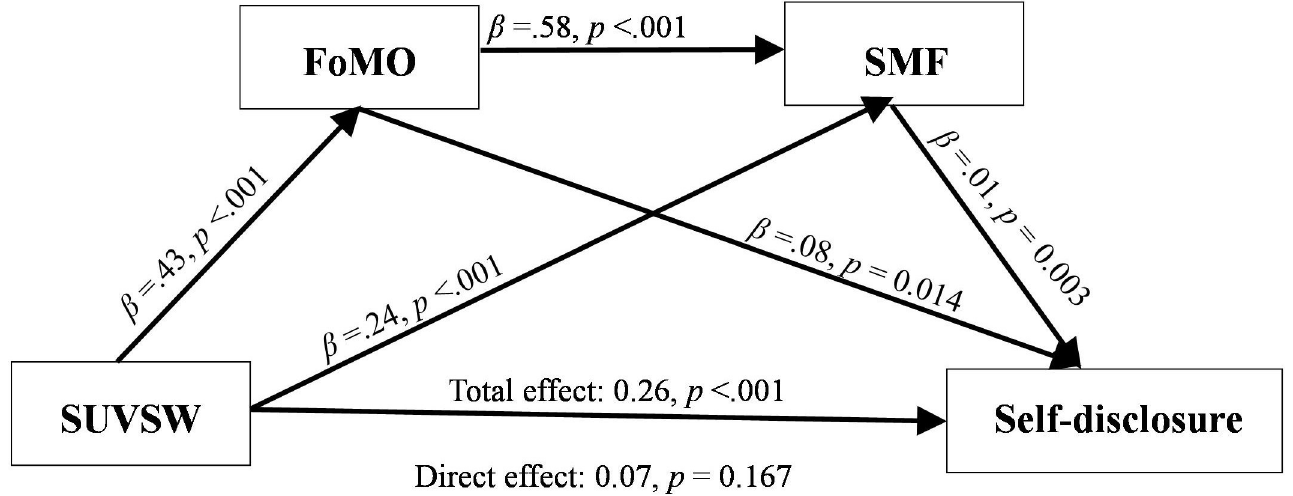
Fig 3. Relationship of SUVSW, self-disclosure in social media, SMF and